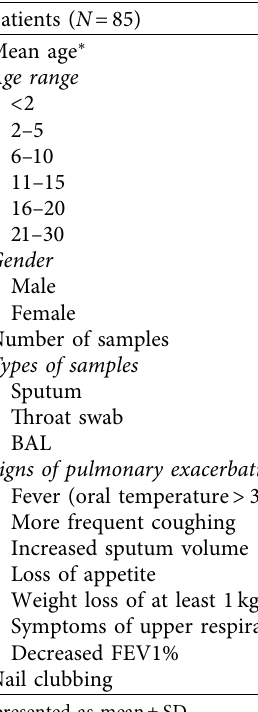
Table 1: Patients’ demographic data and clinical